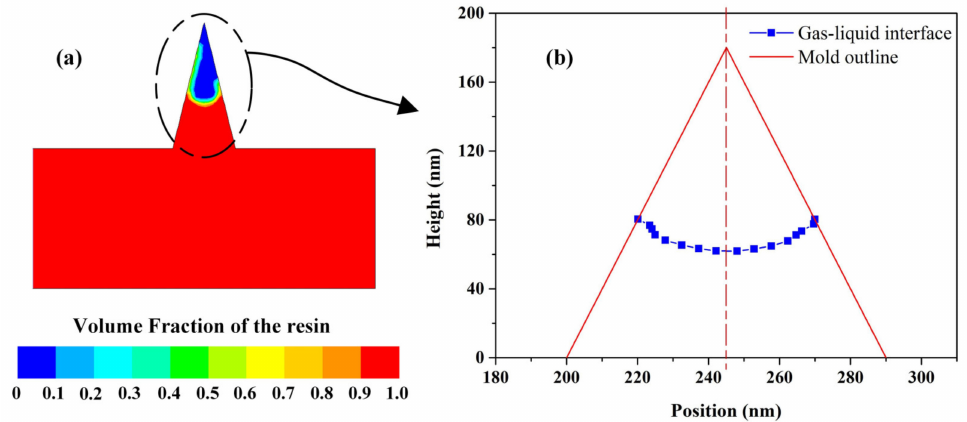
Figure 6. The filling height of moth-eye nanostructure from the simulation results. ( a ) the resin volume fraction in the mold cavity, ( b ) the interface between resin and